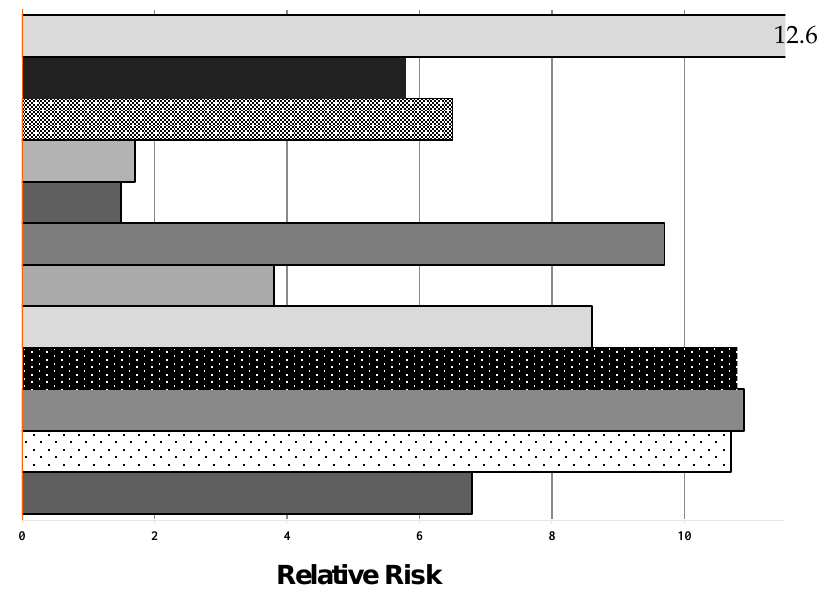
Figure 3. Early risk of death in patients with AS and LV systolic dysfunction undergoing AVR.